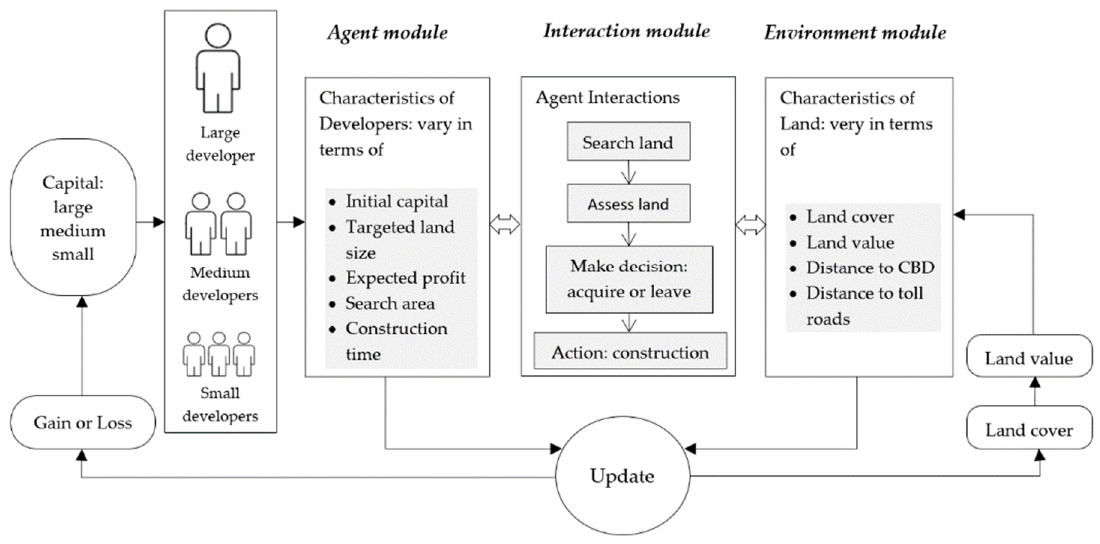
Figure 2. Conceptual framework of agent-based modelling (ABM) with multiple types of developers in the urban development process.